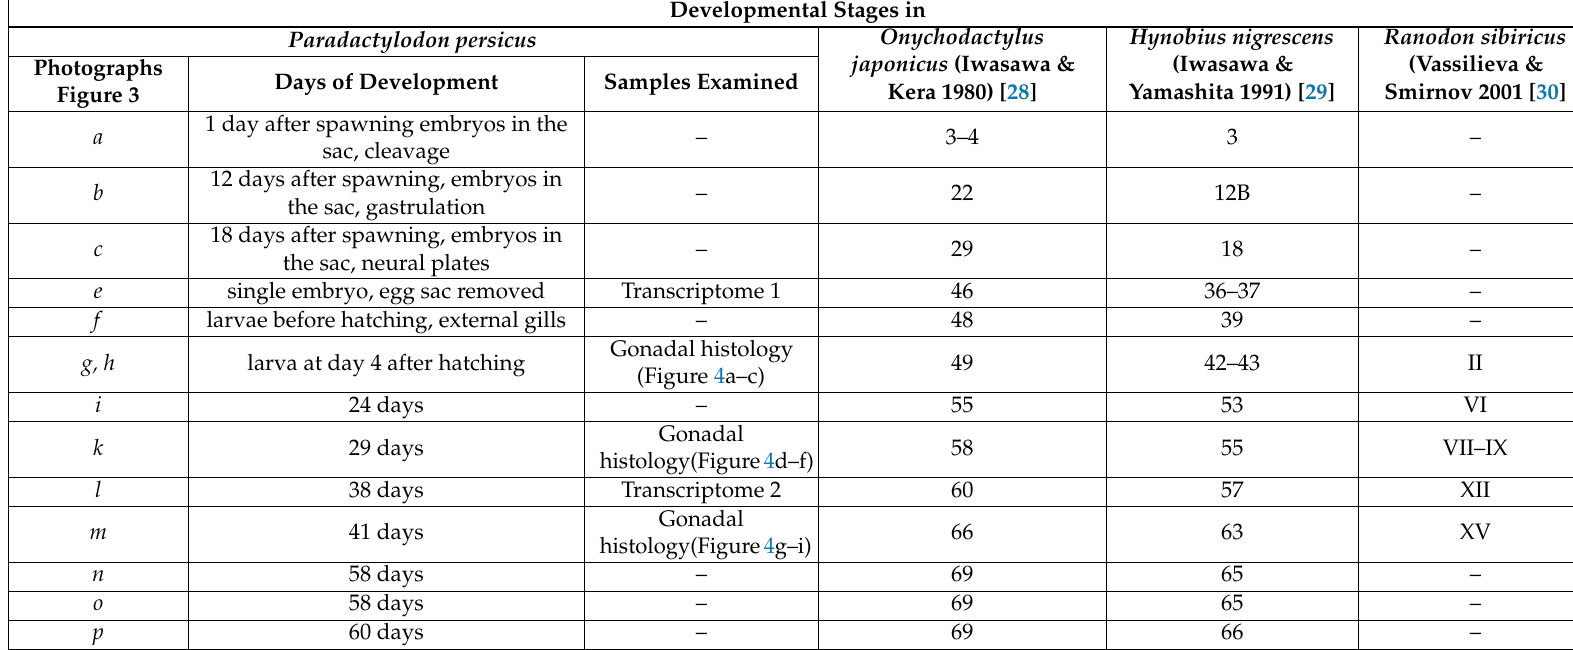
Table 1. Developmental stages and samples taken for transcriptomics and gonadal histology of Paradactylodon in comparison to stages in three genera of hynobiid salamanders ( Onychodactylus , Hynobius , and Ranodon ), according to di ff erent